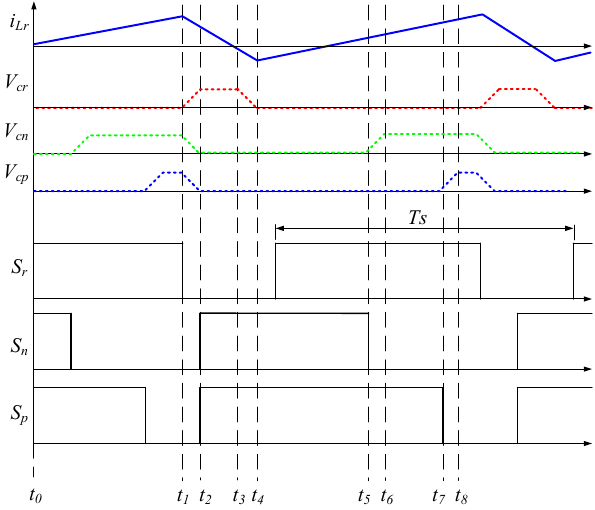
Figure 8. The key waveforms of the proposed soft-switched rectifier.